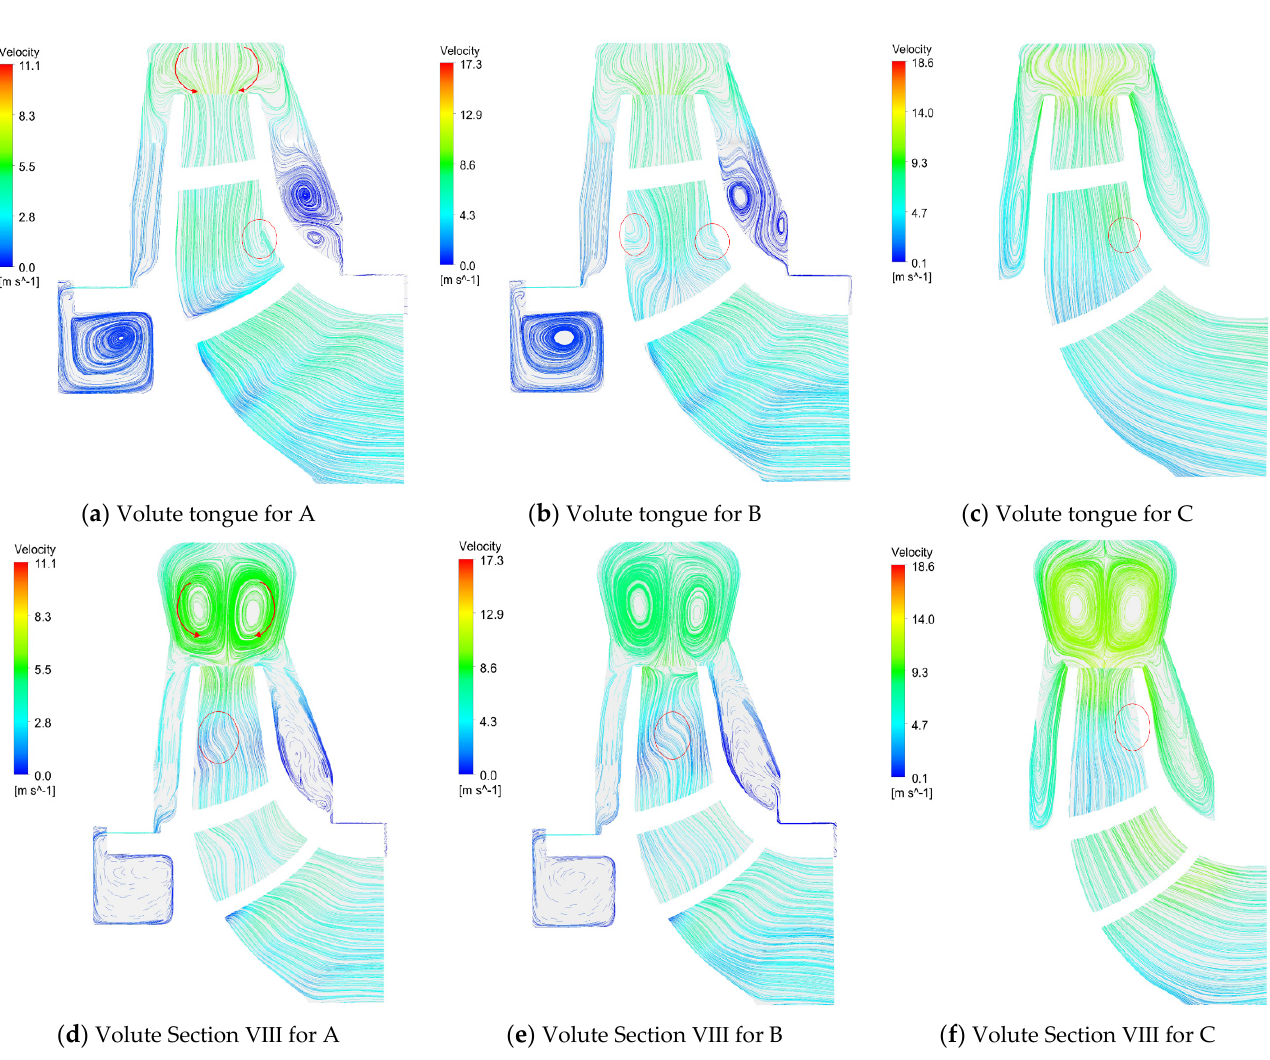
Figure 9. Flow profile of rotor axial surface and volute section Ⅷ .